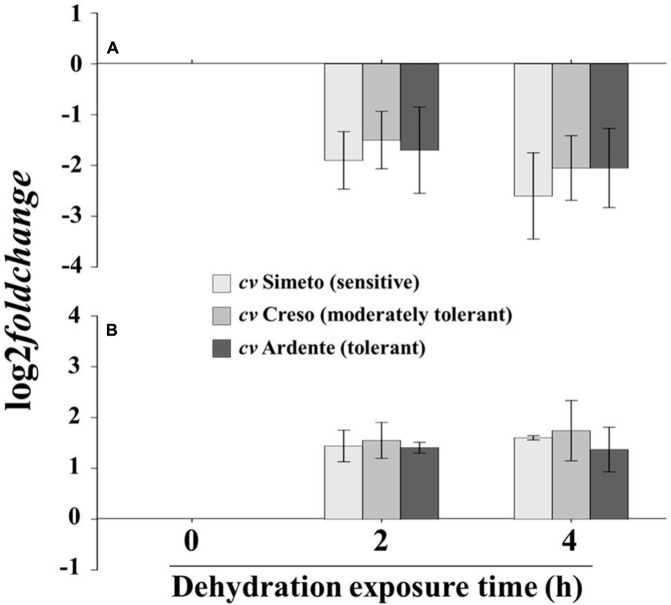
XTH expression profile in excised segment extracts of (A) the first 5 mm of the root apical region and (B) the root sub-apical region of 3-day-old wheat seedlings (cultivar Simeto, Creso, and Ardente) subjected to drought stress for 2 and 4 h. XTH expression is reported as decrease in transcript level (log2 fold change) with respect to time 0 (control). Data are the mean ± standard deviation of three independent replicates (n = 3).